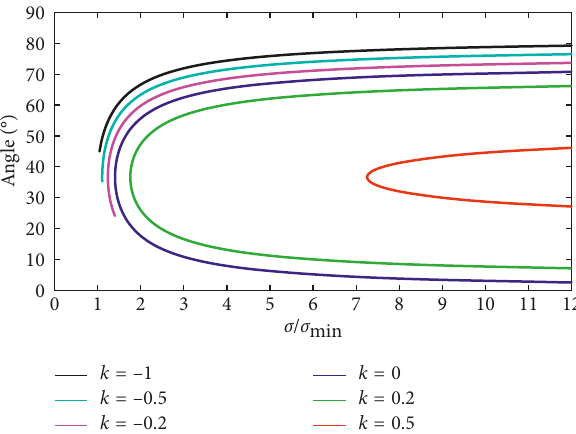
Figure 4: Relation between critical shear stress and crack dip at different stress ratios.